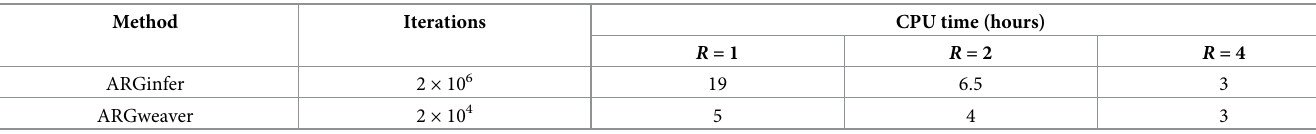
Table 1. Computation time for ARGinfer and ARGweaver